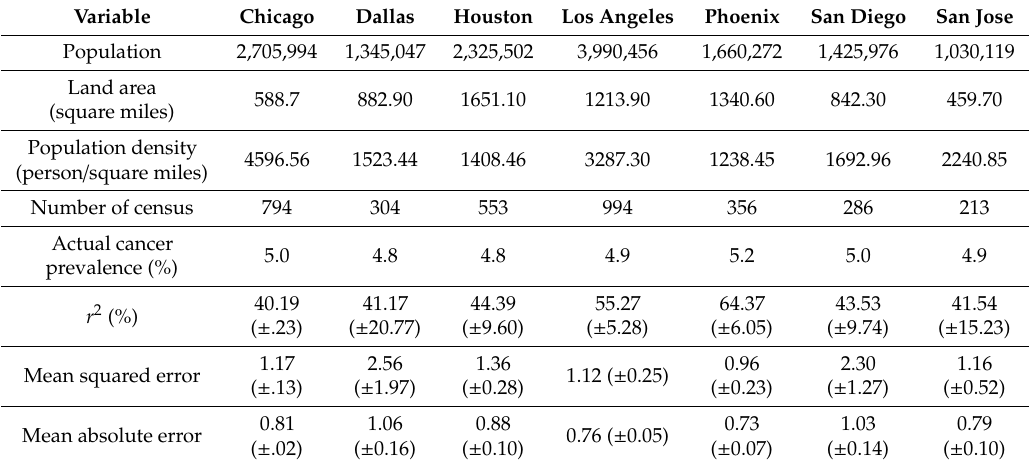
Table 1. Characteristics and results for the cities included in the study ( +/ − 95% confidence interval).